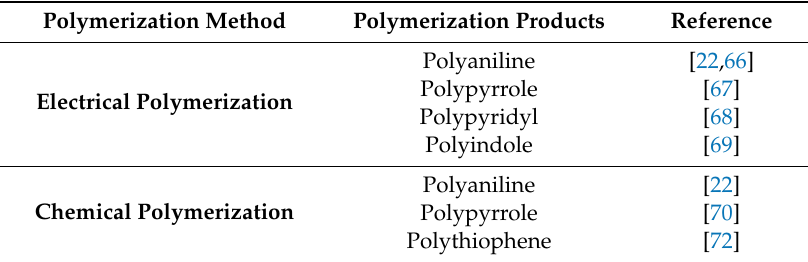
Table 2. Conductive polymer synthesis